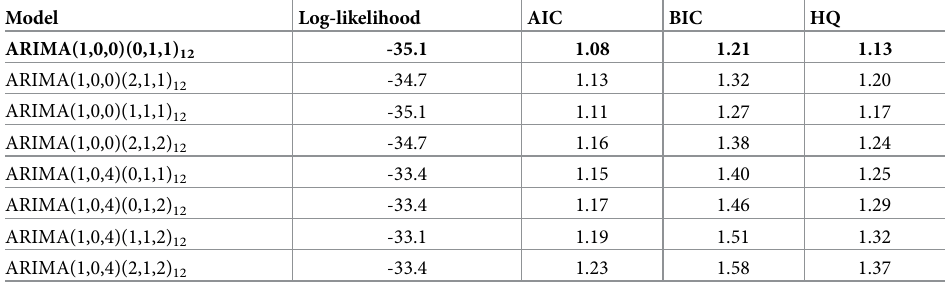
AIC- Akaike information criterion, BIC- Bayesian information criteria, HQ-Hannan-Quinn information